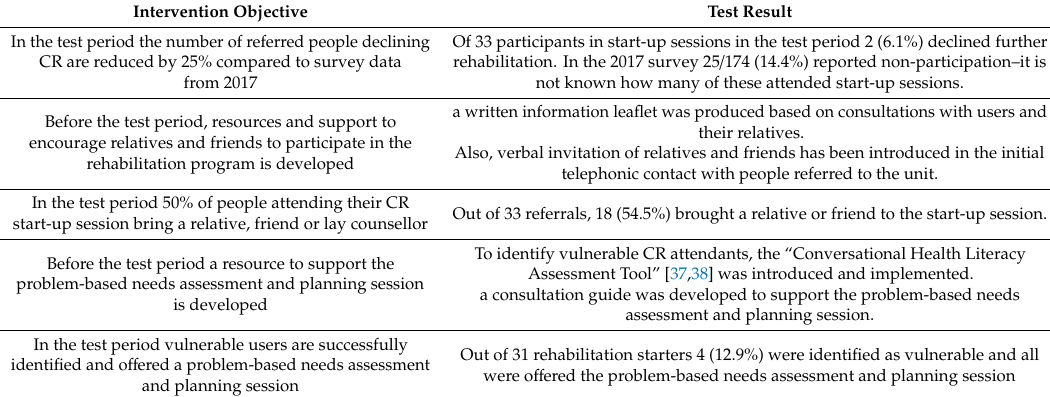
Table 3. Intervention objectives related to the initial phases of the cardiac rehabilitation (CR) program and results of the second quality improvement